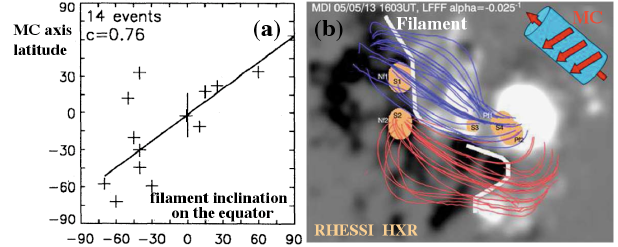
Fig. 6. Observed cases where the erupting filament and the associ- ated MC axis have a comparable orientation. (a) Scatter plot and linear least-squares fits for 14 events. There is a relatively good correlation between the orientation of the filament and the MC axis, but they differ by more than 40 ◦ for the two events (Zhao and Hoek- sema, 1998). (b) Example of association between an erupting fila- ment and its related MC. Some field lines computed with a linear force-free extrapolation (blue and red lines) and the observed hard X-ray sources (pink regions) are added on top of the photospheric magnetogram (Yurchyshyn et al., 2006).